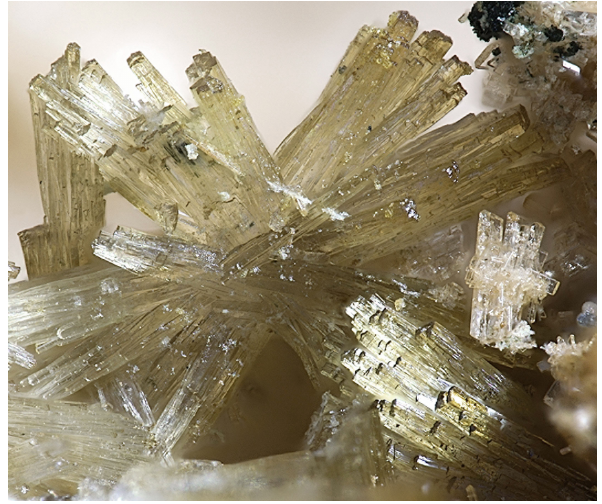
Figure 2. Whiteite-(CaMnFe) crystals, FOV = 0.58mm. Photo taken by Christian Rewitzer.